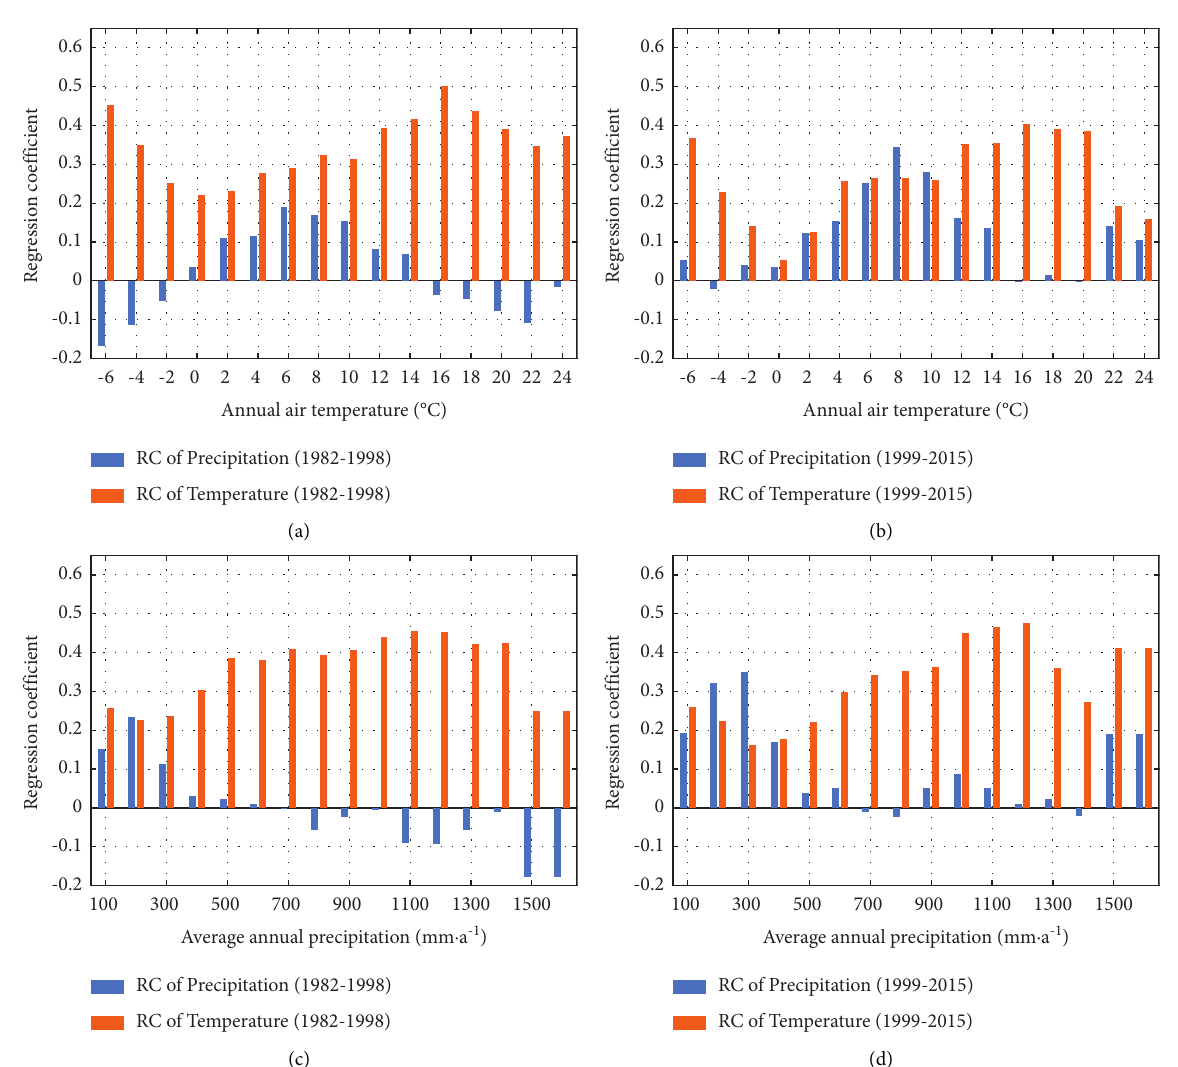
Figure 5: Averaged regression coefficients of precipitation and temperature during the two periods in various bins of ((a) and (b)) annual temperature and ((c) and (d)) annual